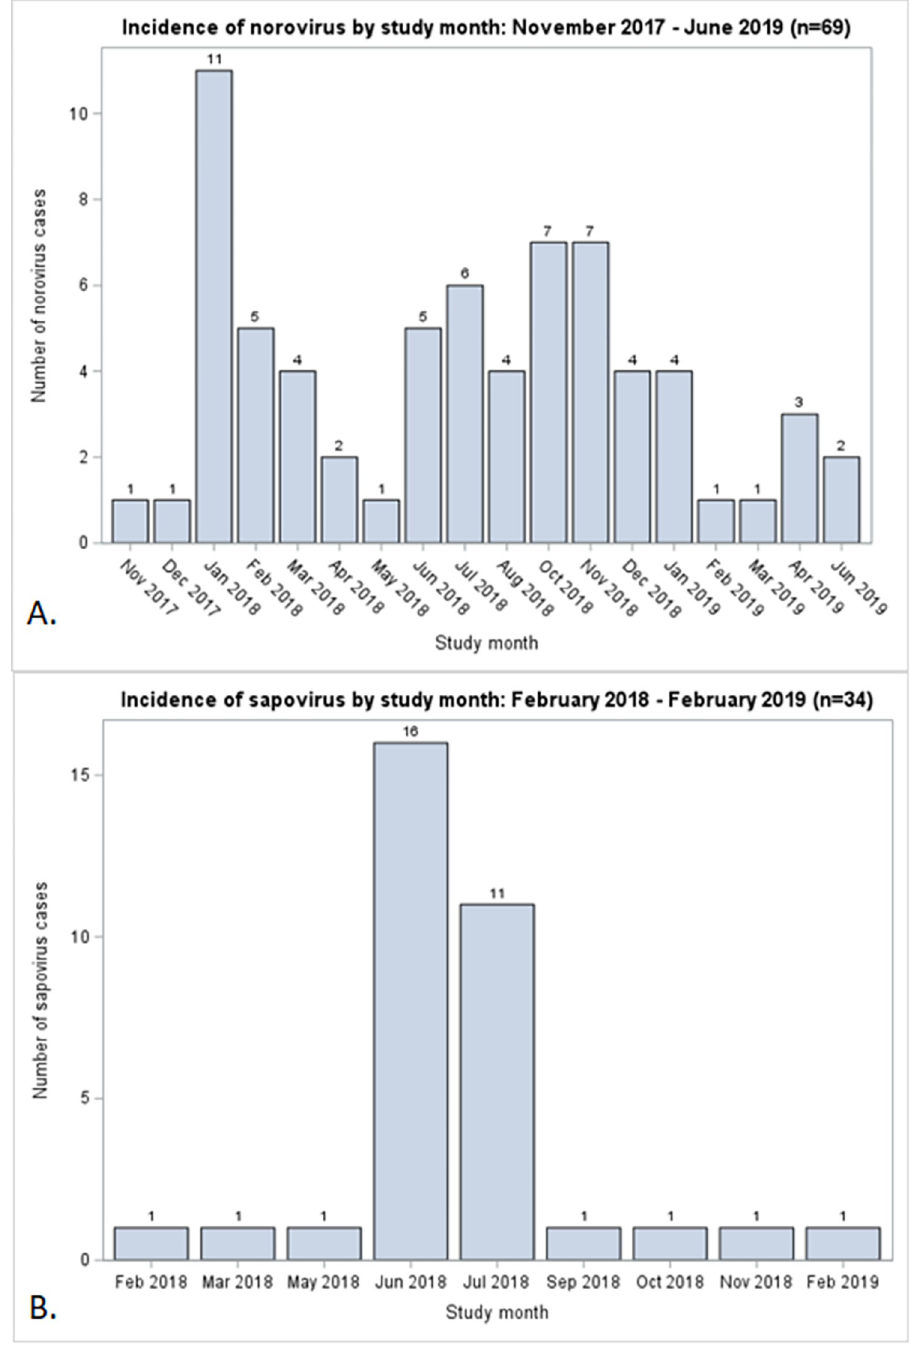
Fig 2. Seasonality of norovirus and sapovirus AGE episodes in the first 12 months of life. This figure illustrates the timing of the 69 first norovirus episodes (Panel A) and the 34 first sapovirus episodes (Panel B) by month and year. norovirus episodes (HR: 1.09, 95% CI: 0.62, 1.92) (Table 3). In this model, child secretor-posi- tive phenotype was the strongest risk factor for norovirus AGE (HR: 11.02, 95% CI: 1.50, 80.80), whereas mother secretor-positive phenotype was the strongest protective factor for